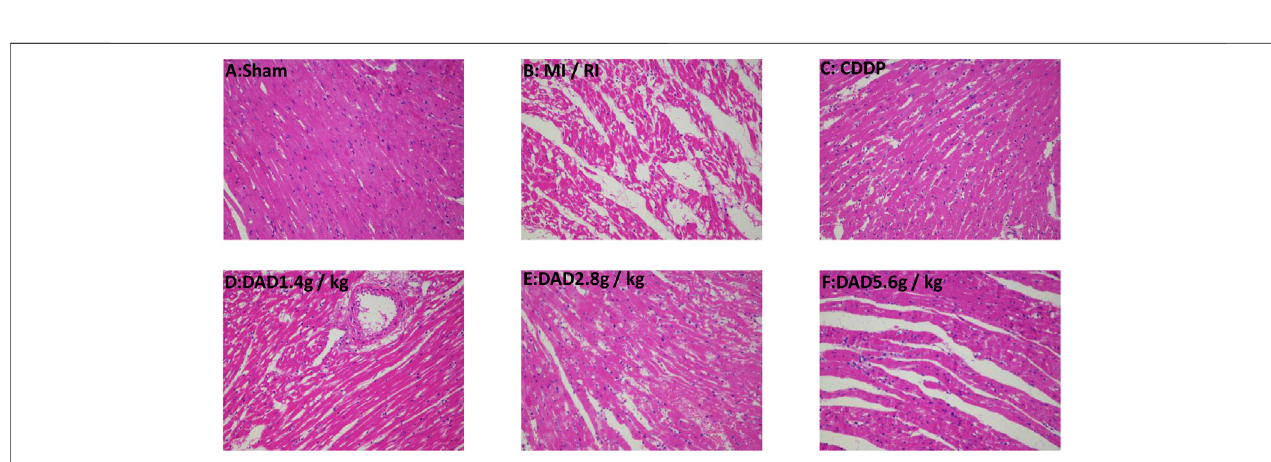
FIGURE 6 | Representative myocardial tissue histopathological sections on the effects of dried ginger-aconite decoction on myocardial infarction size in MI/RI rats (200 × ). Myocardial tissue injury was assessed by hematoxylin-eosin (H&E) staining.